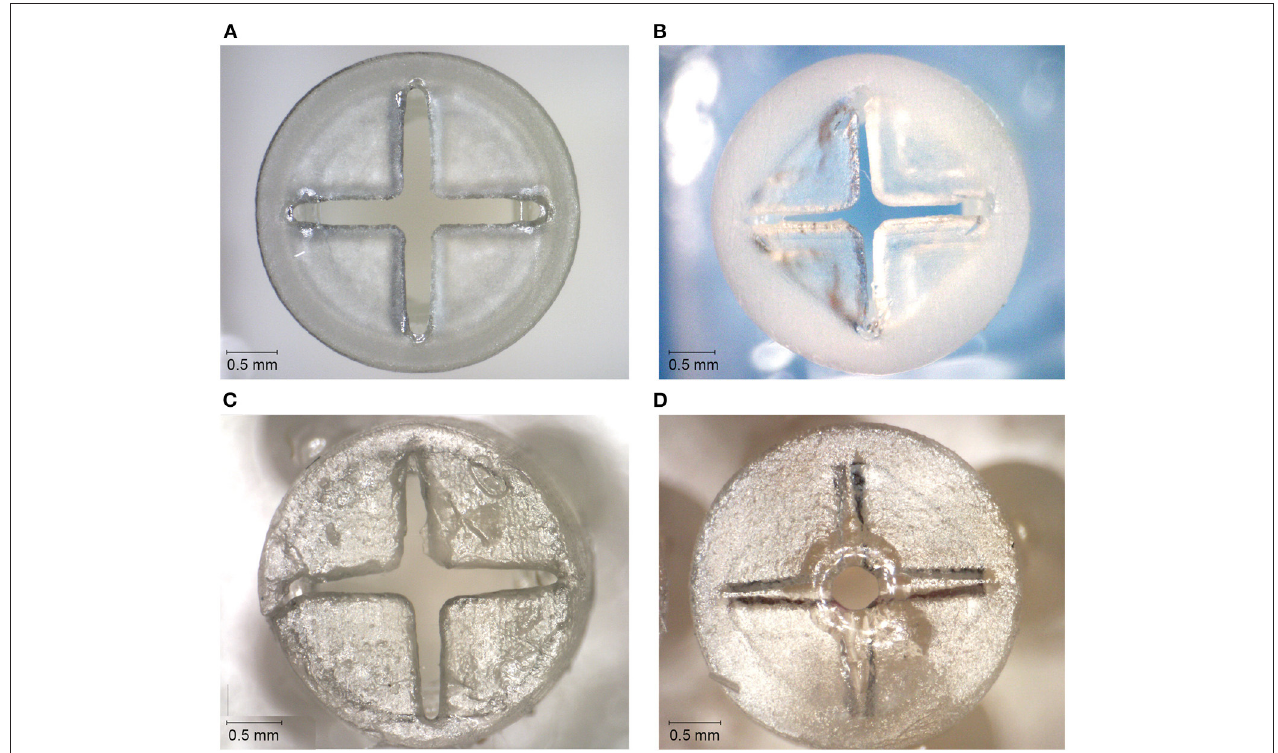
FIGURE 4 | Top surfaces of the 3D printed valves with the smallest top-and slit dimensions for different materials. (A) Valve printed in Dental SG. (B) Valve printed in Durable. (C) Valve printed in Elastic 50A. (D) Valve printed in Flexible 80A, with only an opening in the center of the